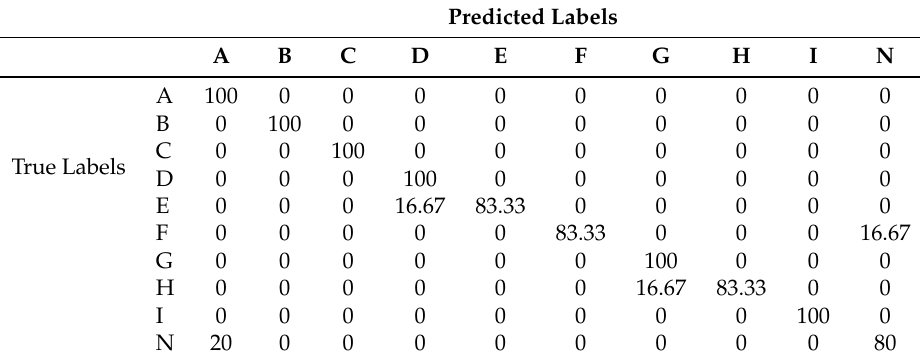
Table 11. Confusion Matrix Calculated for Power + Audio ENF Testing Data–Accuracies